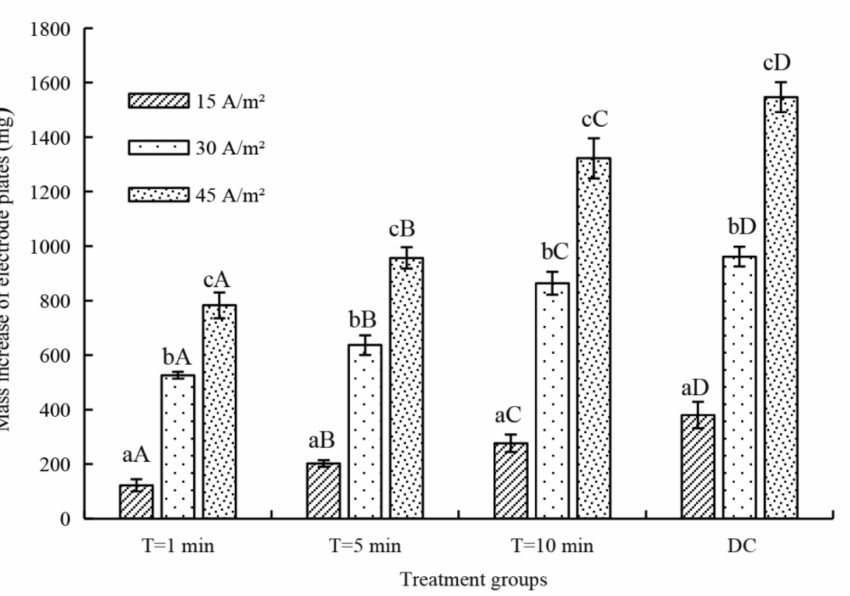
Figure 2. Changes in electrode mass after operating the EC − filtration system for 90 min under different current densities and CCPs. (In the same CCP group, different lowercase letters on some values indicate significant differences ( p < 0.05). At the same current density across different CCPs, different uppercase letters on some values indicate significant differences ( p <